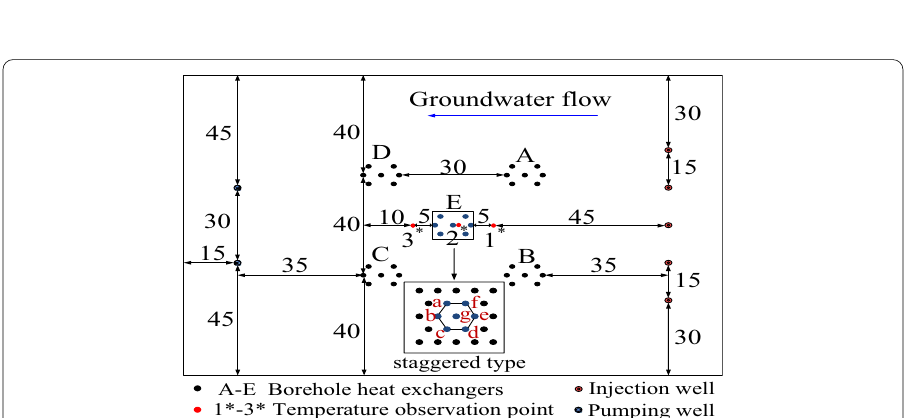
4π λ e Δ ¯ T /q ) change over Fo =